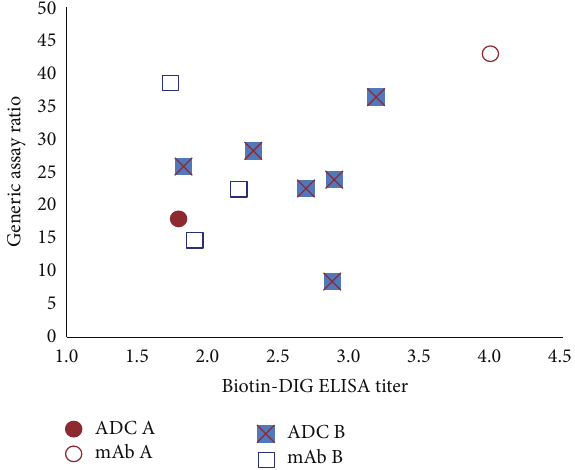
Figure 8: Good agreement between ADA titers by biotin-DIG ELISA and relative ADA ratios by the plug-and-play assay. The figure summarizes the relative levels of ADA Studies 1 (ADC A and mAb A) and 2 (ADC B and mAb B) whose samples were determined as positive by two ADA methods. The ratios calculated in the plug-and-play assay were plotted versus the titers determined in the biotherapeutic-specific biotin-DIG ELISAs. Overall, good agreement between the two procedures was